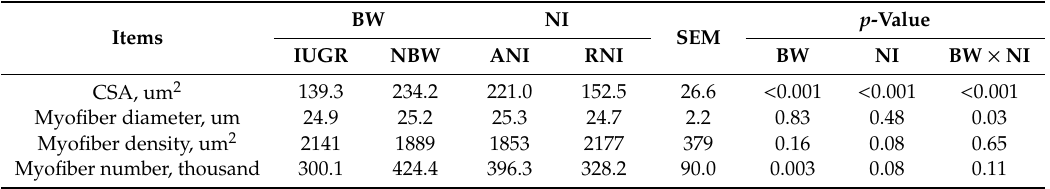
Table 5. E ff ects of the level of nutrient intake on myofiber characteristics of psoas major muscles in intrauterine growth-retarded (IUGR) and normal-birth weight (NBW) piglets.